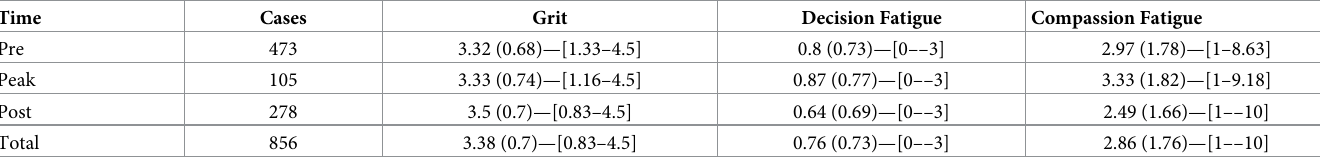
Table 2. Overall descriptive statistics for the key variables of the